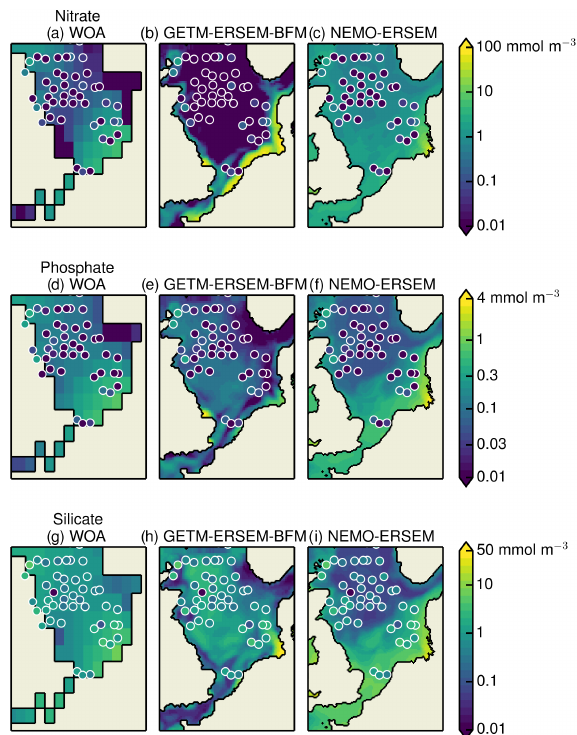
Figure 9. Maps of monthly mean sea surface nitrate (a–c) , phos- phate (d–f) , and silicate (g–i) for August 2010: World Ocean Atlas climatology (a, d, g) , GETM-ERSEM-BFM (b, e, h) , and NEMO- ERSEM (c, f, i) . The in situ IBTS surface observations from August 2010 are overlaid in circles.